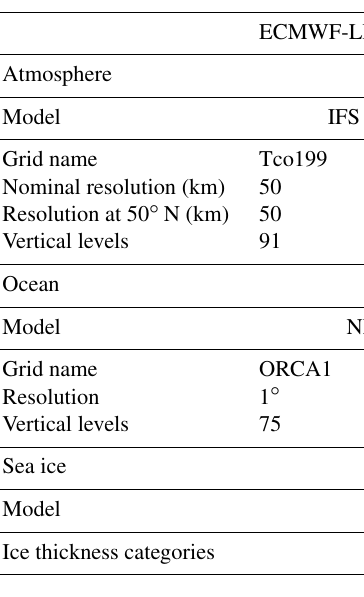
Table 1. Characteristics of the two models at two different resolutions used in this